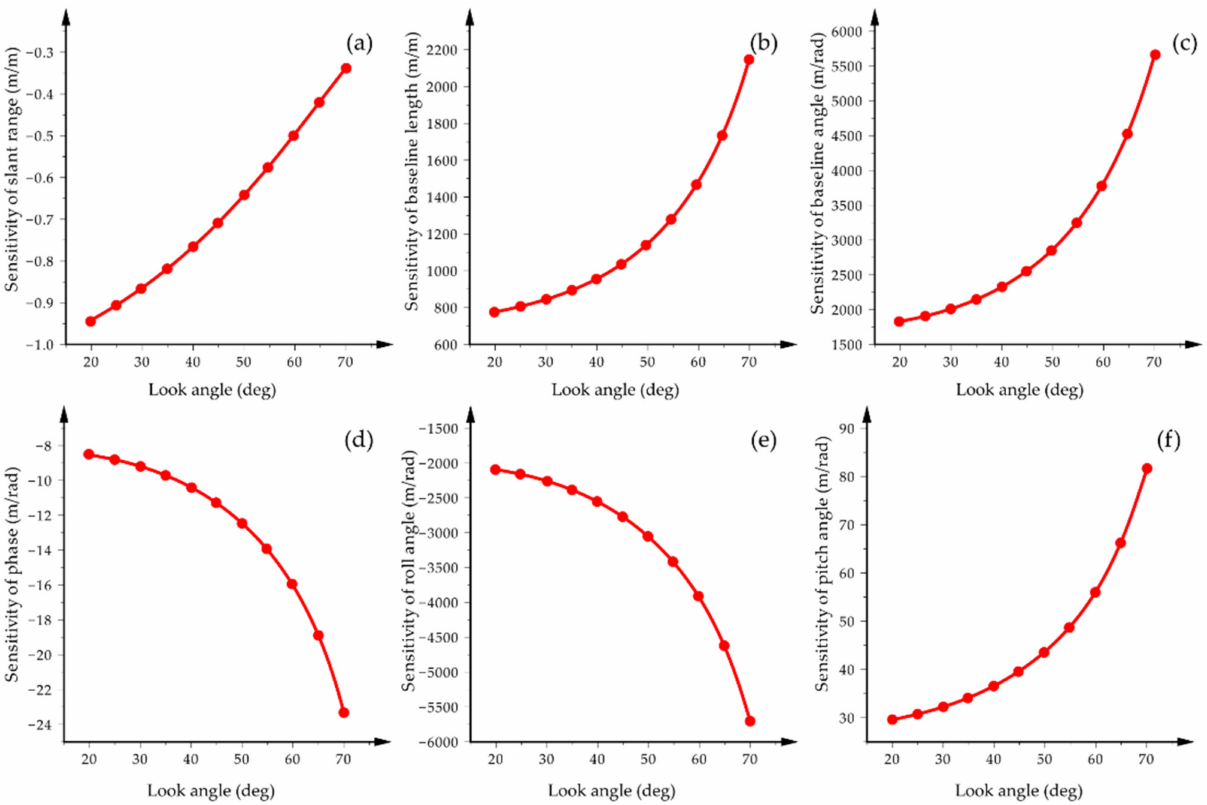
Figure 9. Height error sensitivity of ( a ) slant range, ( b ) baseline length, ( c ) baseline angle, ( d ) interfer- ometric phase, ( e ) roll angle, and ( f ) pitch angle with given parameters for a single scene.